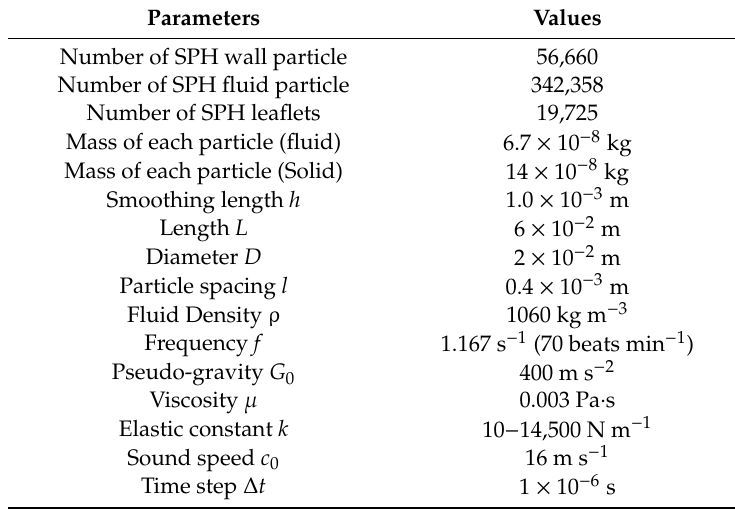
Table 1. Model parameters used in the simulation; for the meaning of SPH parameters such as α or h , refer to Liu and Liu, 2003 [21].